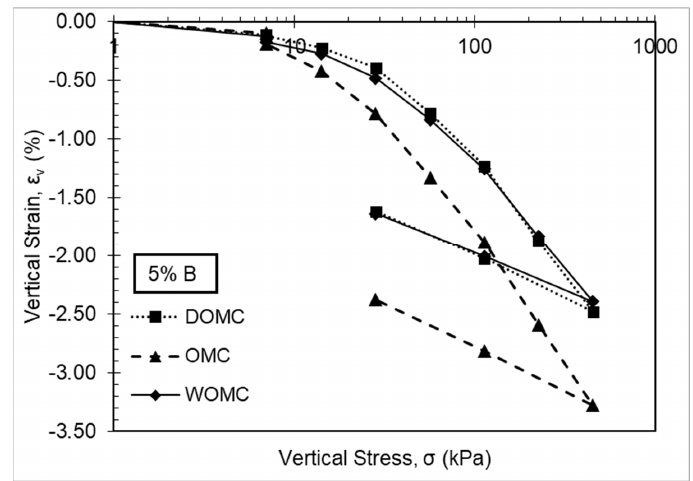
Figure 7. Consolidation tests for compacted 5% bentonite clay–sand mixture with three moisture contents.